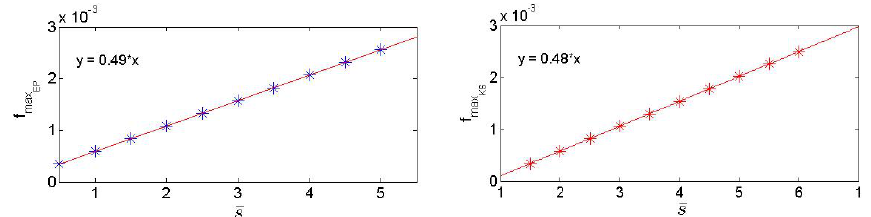
Figure 4. f max (left) and f max (right) as functions of s for α = 0 . 5 and N = 100. Both f max EP KS = 0 . 5. slope respectively 0 . 48 and 0 . 49, close to 1 4 α